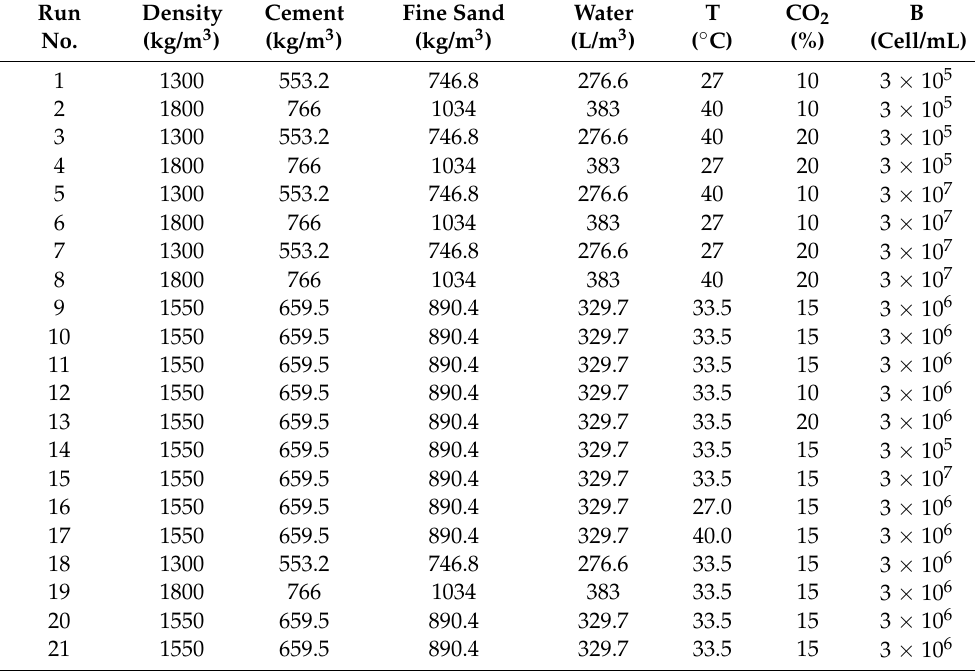
Table 4. Concrete mixture and RSM design for the optimization